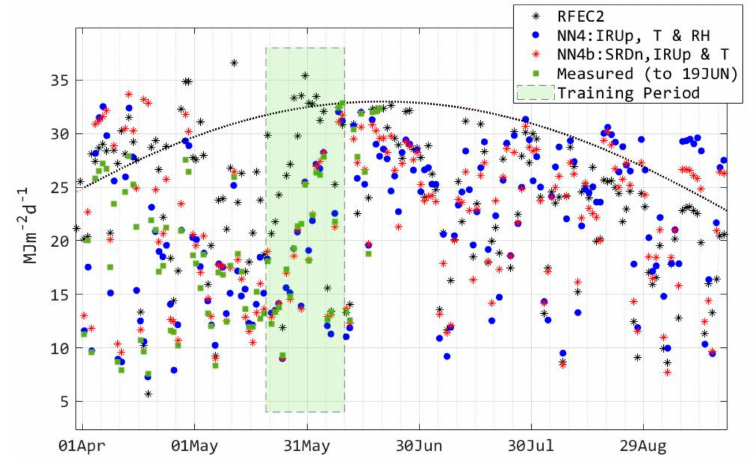
Figure 4. Measured and modelled daily irradiance with the clear sky envelope (dashed line). Period of record used for training NN models is indicated by shaded